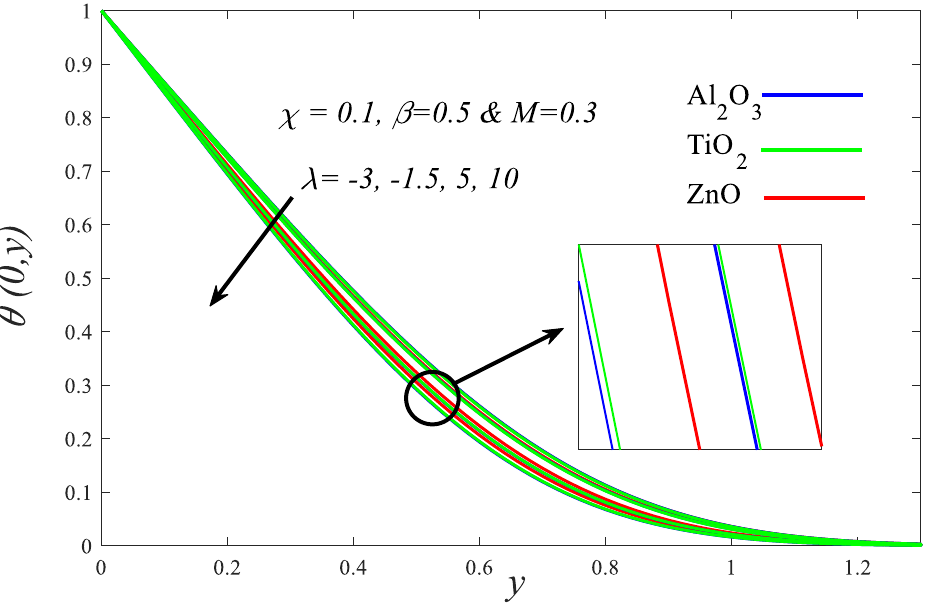
Figure 10. Impression of λ on θ . The inset is a partial enlargement of the curves.